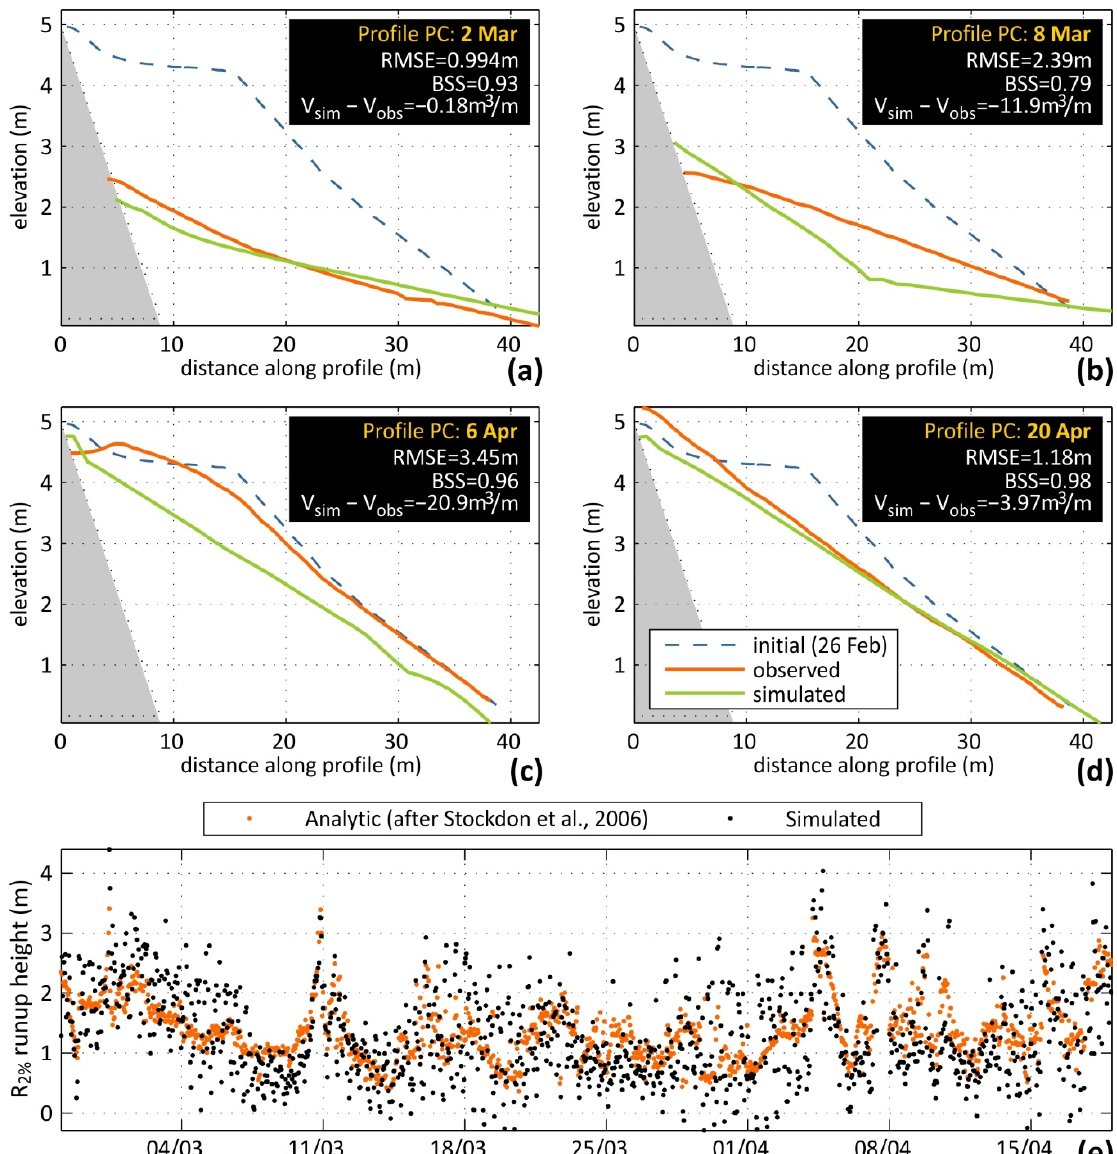
Figure 7. Calibration results for profile PC (see Figure 1 for location): ( a – d ) show the goodness of fit between simulated (green line) and observed (orange line) profiles for 2 and 8 March and 6 and 20 April, respectively (RMSE, BSS and total volume difference between simulation and observation (V sim − V obs ) are given in the legend); the time-series of theoretic (orange dots, after [46]) and simulated (black dots) R 2% runup heights are given in ( e ).